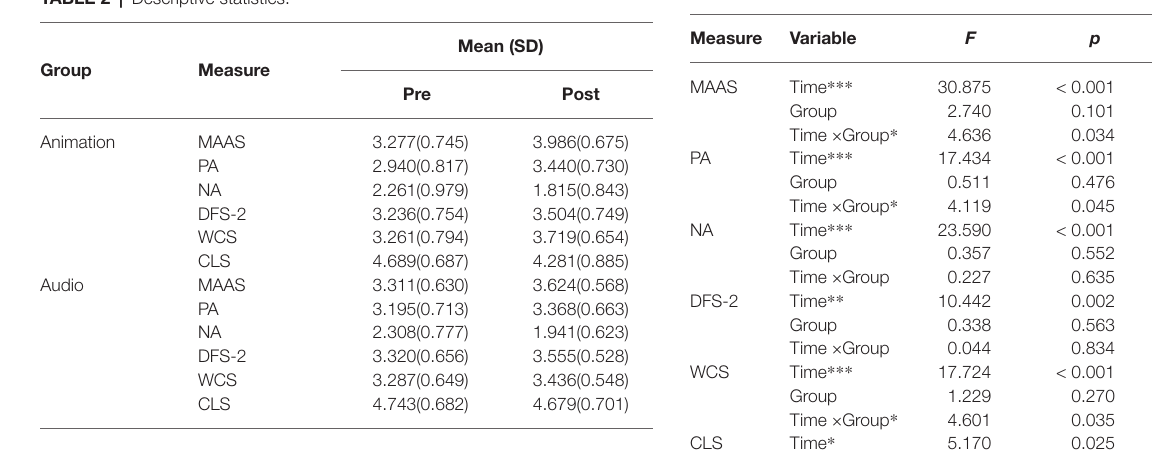
TABLE 2 | Descriptive statistics. TABLE 3 | ANOVA